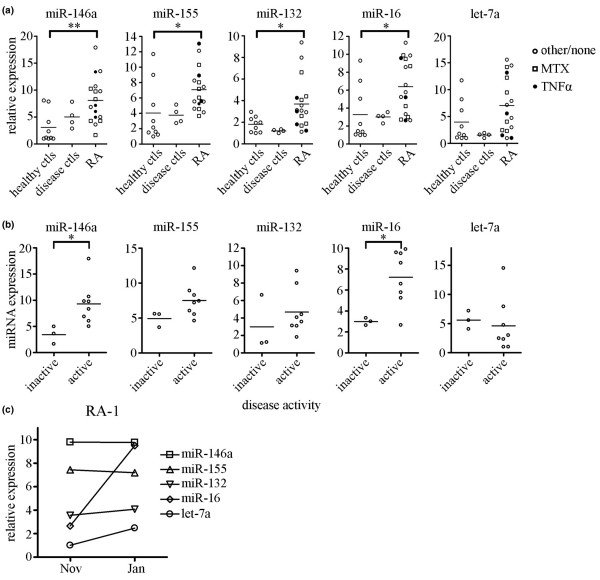
RA patients exhibit aberrant expression of miR-146a, miR-155, miR-132 and miR-16 versus healthy controls. (a) RNA was isolated from healthy control individuals (n = 9), disease control individuals (n = 4), and RA patient (n = 17). PBMCs and relative expression levels of miR-146a, miR-155, miR-132, miR-16, and miRNA let-7a were analyzed by qRT-PCR using U44 RNA as an internal control. Average is indicated by bars. *P < 0.05, **P < 0.01, as determined by one-way analysis of variance. For RA patients, closed circles indicate patients undergoing anti-TNF-α therapy at time of sample collection, squares indicate MTX treatment, and open circles indicate other or no treatment. (b) Disease activity was determined for patients using CRP and ESR values and correlated with miRNA expression. Normal CRP and ESR values were classified as inactive disease (n = 3; patients 9, 12, and 14 in Table 1), and higher than normal CRP or ESR values were classified as active disease (n = 8; patients 1a, 1b, 2, 4, 5, 6, 10, and 15 in Table 1). Those patients with no or incomplete data for CRP/ESR values were omitted. *P < 0.05, as determined by t-test. (c) PBMCs were collected from patient RA-1 before (November 2007) and after (January 2008) MTX treatment and miRNA expression was examined using qRT-PCR. miRNA expression is largely consistent over time, with the exception of increased miR-16 expression. CRP, C-reactive protein; ESR, erythrocyte sedimentation rate; miRNA, microRNA; MTX, methotrexate; PBMC, peripheral blood mononuclear cell; qRT-PCR, quantitative real-time RT-PCR; RA, rheumatoid arthritis; RT-PCR, reverse transcription polymerase chain reaction; TNF, tumor necrosis factor.